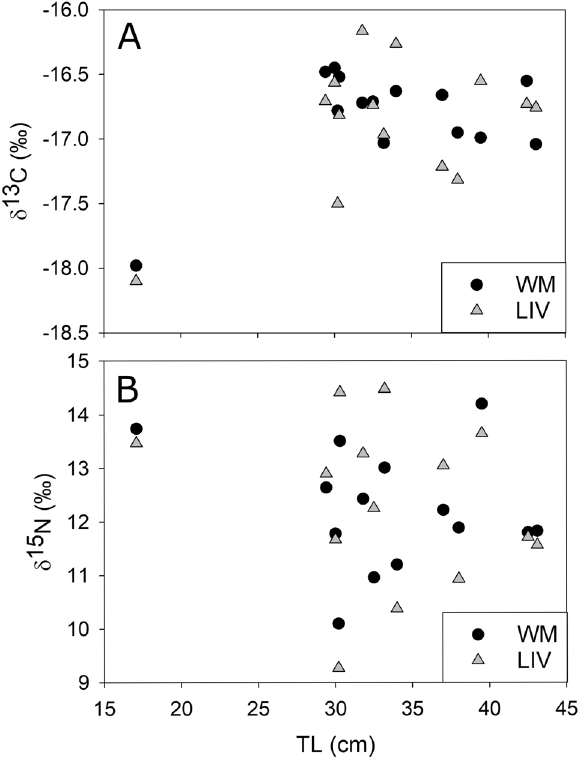
Figure 1. Carbon ( A ) and nitrogen (b) stable isotope composition of Cookiecutter shark tissues ( WM white muscle, LIV liver) by length. There was no significant relationship (linear regression, p > 0.05) between δ 13 C and δ 15 N and length for white muscle (solid lines, δ 13 C r 2 = 0.12, δ 15 N = 0.04) and liver (dashed lines, δ 13 C r 2 = 0.15, δ 15 N =